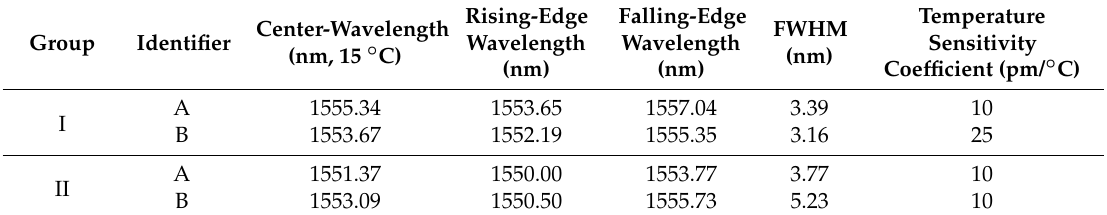
Table 2. The detailed parameters of the cFBGs used in the